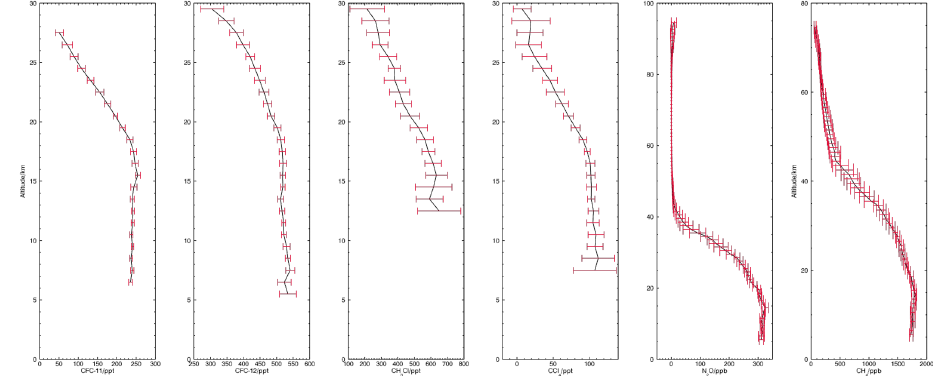
Figure C7 The mean vertical profile of CFC-11, CFC-12, CH3Cl, CH4 & N2O, calculated using data from 2009 between 0° and 15° South Fig. C8. The mean vertical profile of CFC-11, CFC-12, CH 3 Cl, CCl 4 , N 2 O and CH 4 , calculated using data from 2009 between 0 ◦ and 15 ◦ S.